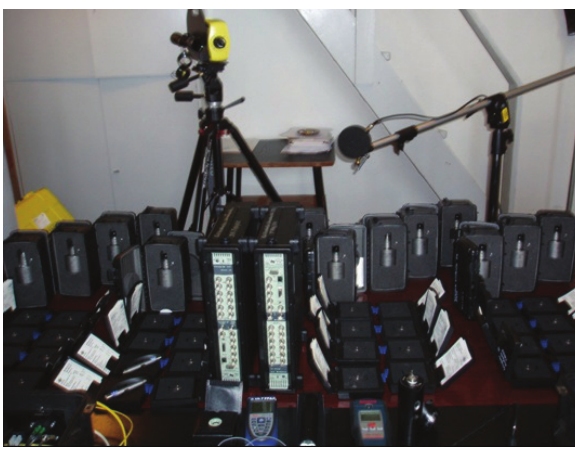
Figure 3: Measurement instruments—PULSE system by Brüel &